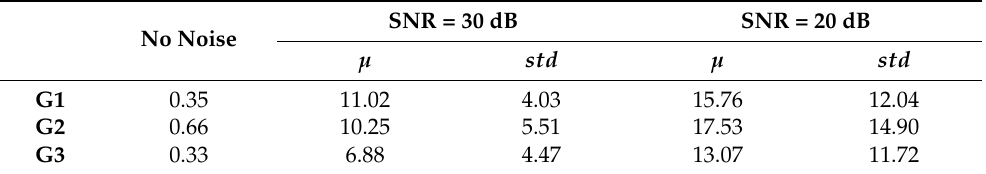
Table 4. Inertia estimation via the direct use of the swing equation. Computed PE under different noise levels. SNR = 30 dB SNR = 20 No Noise